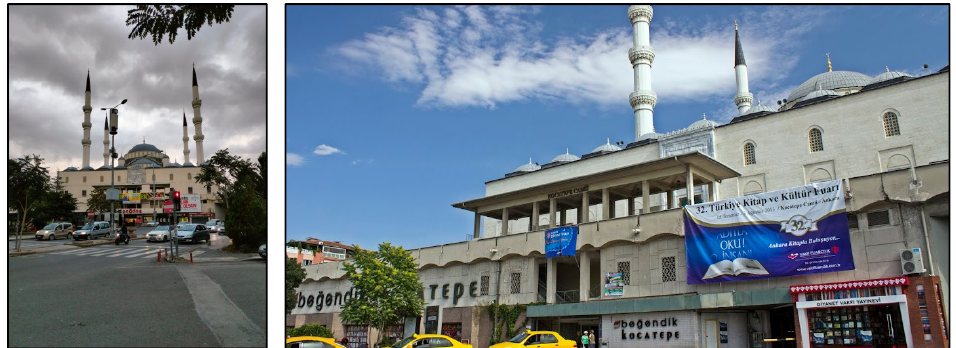
Figure 4. Ankara Kocatape Mosque.